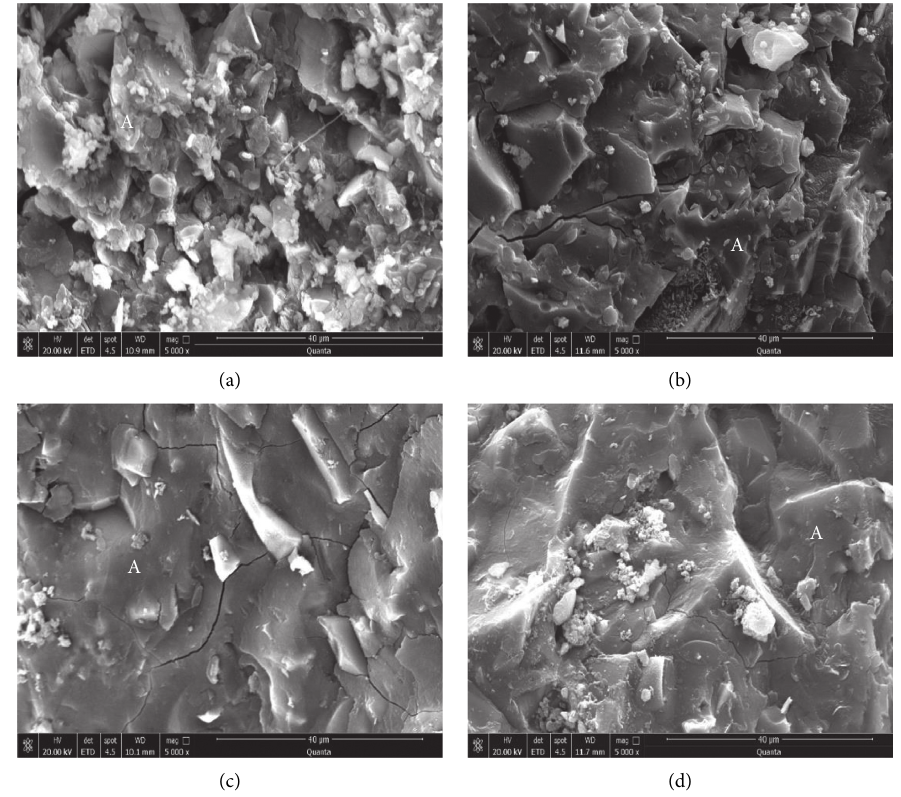
Figure 9: SEM images of NS9.75-NC2.82 (magnification: 5000x) at one day (a); three days (b); seven days (c); 28 days